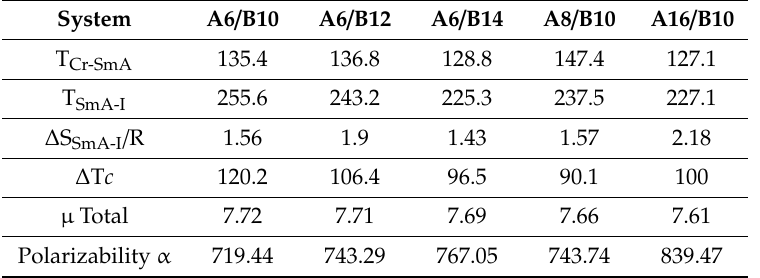
Table 3. Dipole moment ( µ ), polarizability ( α ) and the mesophase parameters of SMHBCs An / Bm . System A6 / B10 A6 / B12 A6 /